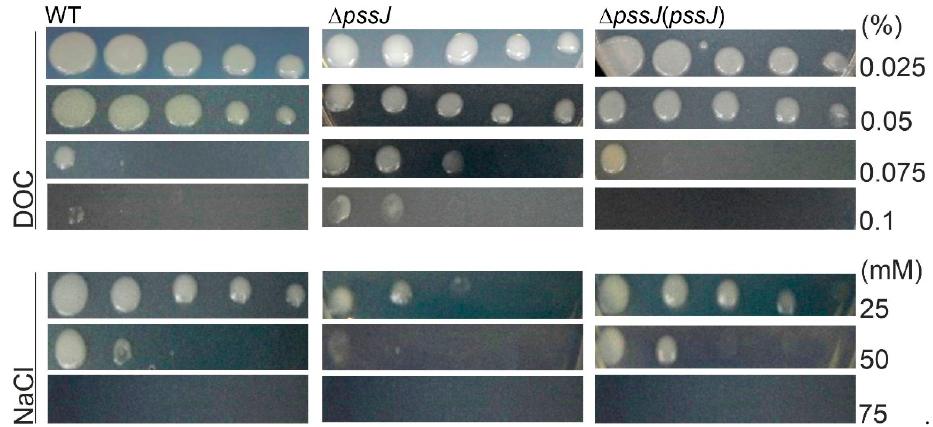
Figure 8. Influence of envelope stressors on the growth of the wild type RtTA1, Δ pssJ , and Δ pssJ ( pssJ ). Sensitivity to deoxycholate (DOC) and NaCl was determined by plating serial 10-fold dilutions of the bacteria on 79CA supplemented with the indicated concentrations of stressors.